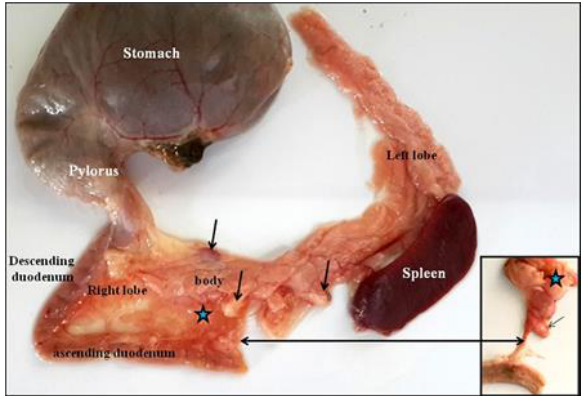
Figure 6. Minor pancreatic duct running through the connecting part of the body (blue star) toward the ascending duodenum. The figure showed many lymph nodes (black arrows).